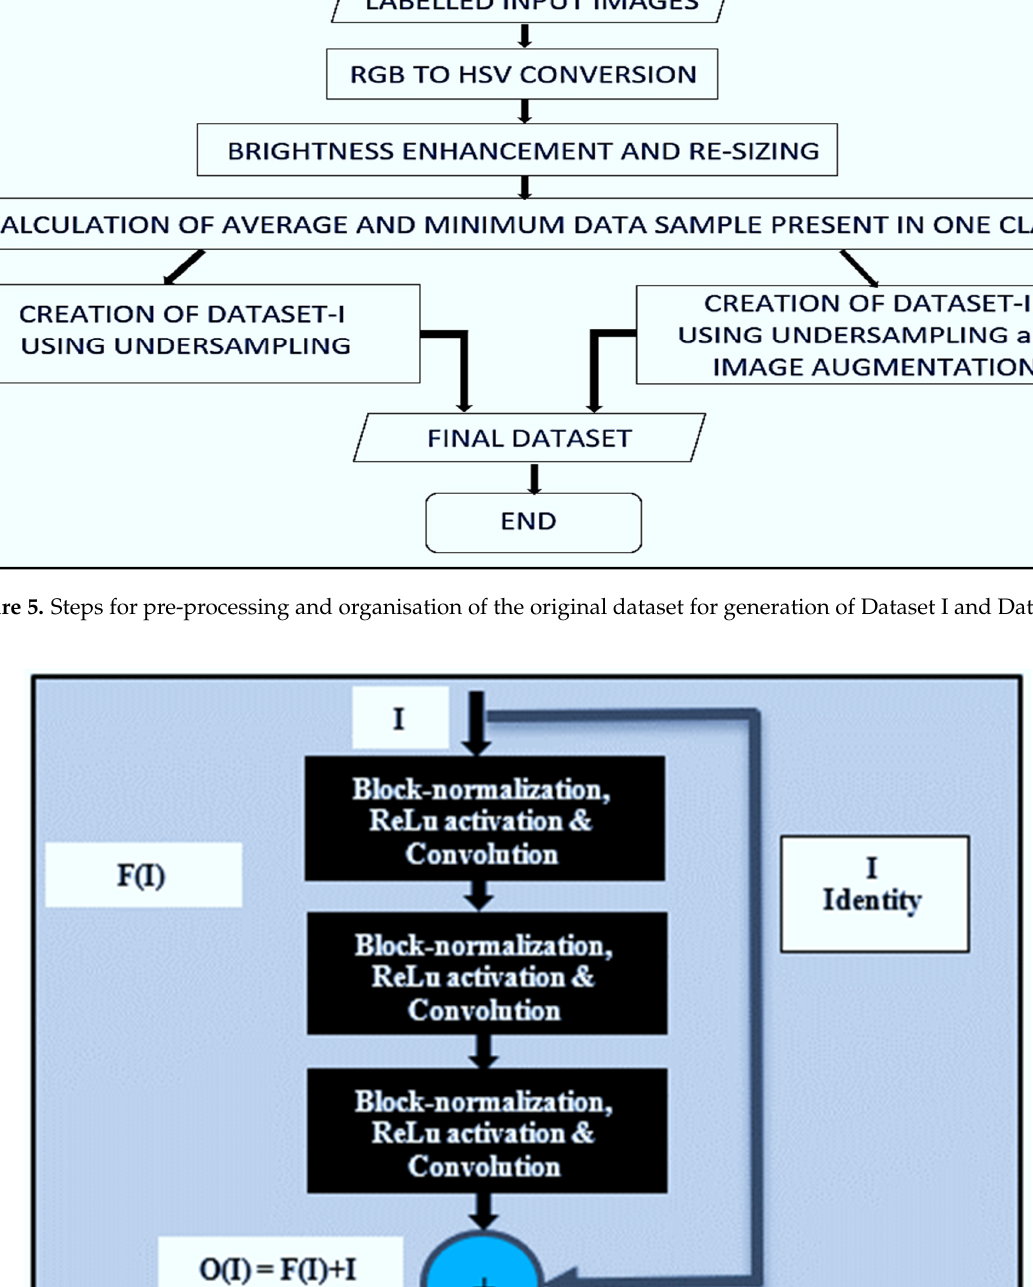
Figure 6. The basic building blocks of residual network version 2: residual learning.